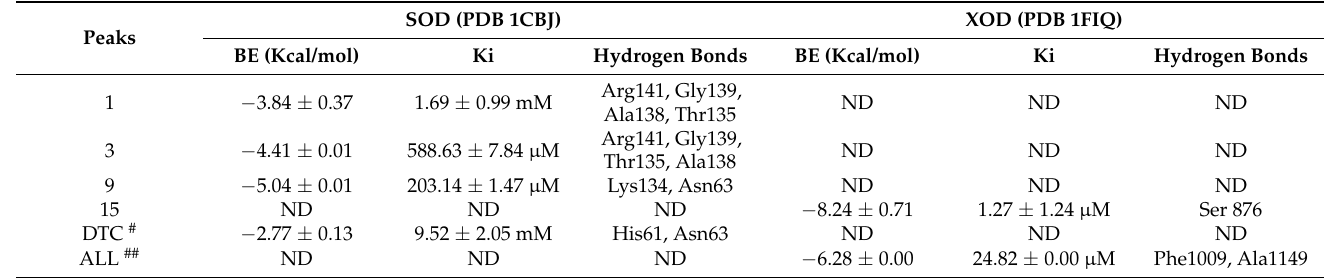
Table 3. Docking ability and affinity of potential ligands with SOD and XOD.